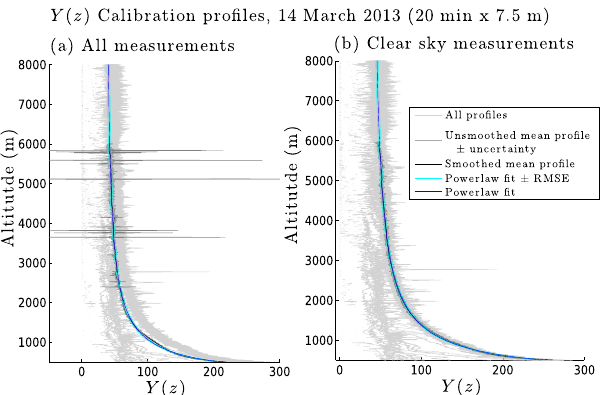
Figure 15. Profiles of fits to Y(z) calibration values for 14 March 2013. Panel (a) uses profiles from all measurements from the mea- surement period, which corresponds to those in box A of Fig. 14. Panel (b) uses only profiles which include clear sky, which are those indicated in box B of Fig. 14. All regions with thick clouds have been